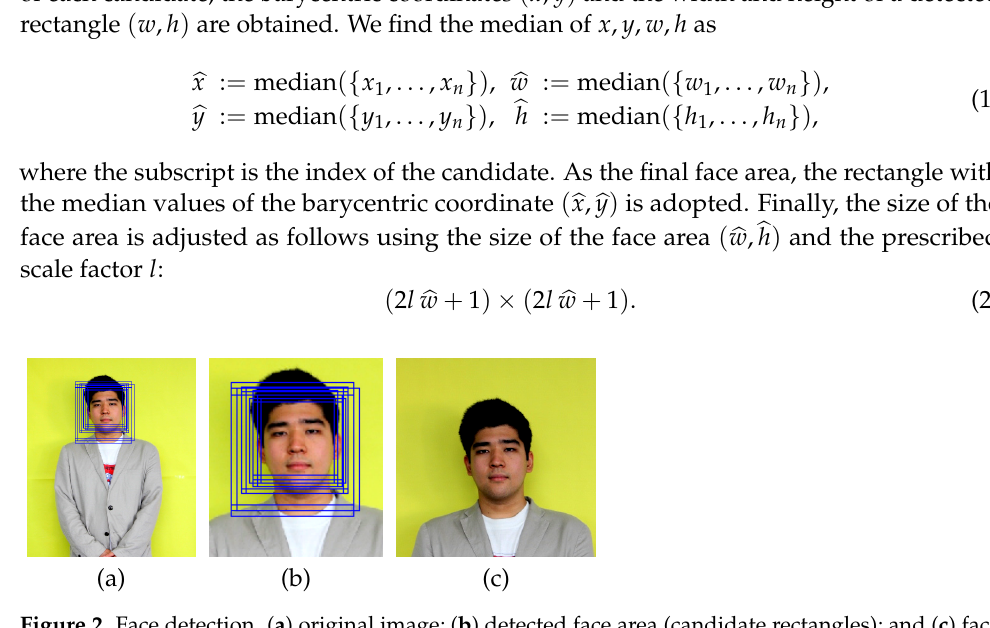
Figure 2. Face detection. ( a ) original image; ( b ) detected face area (candidate rectangles); and ( c ) face area in the original